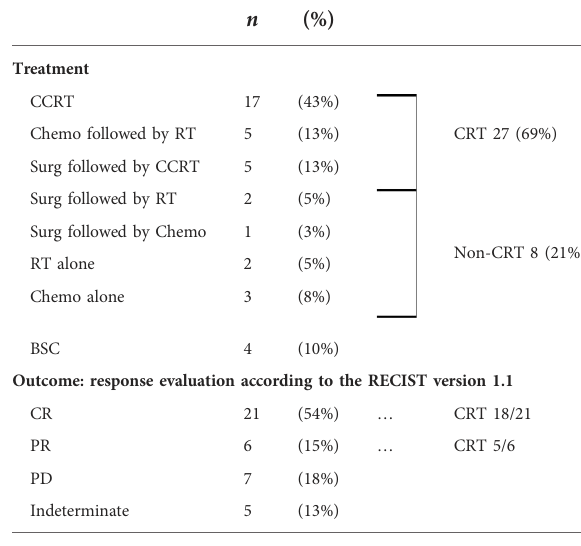
TABLE 4 First-line treatment and outcomes.